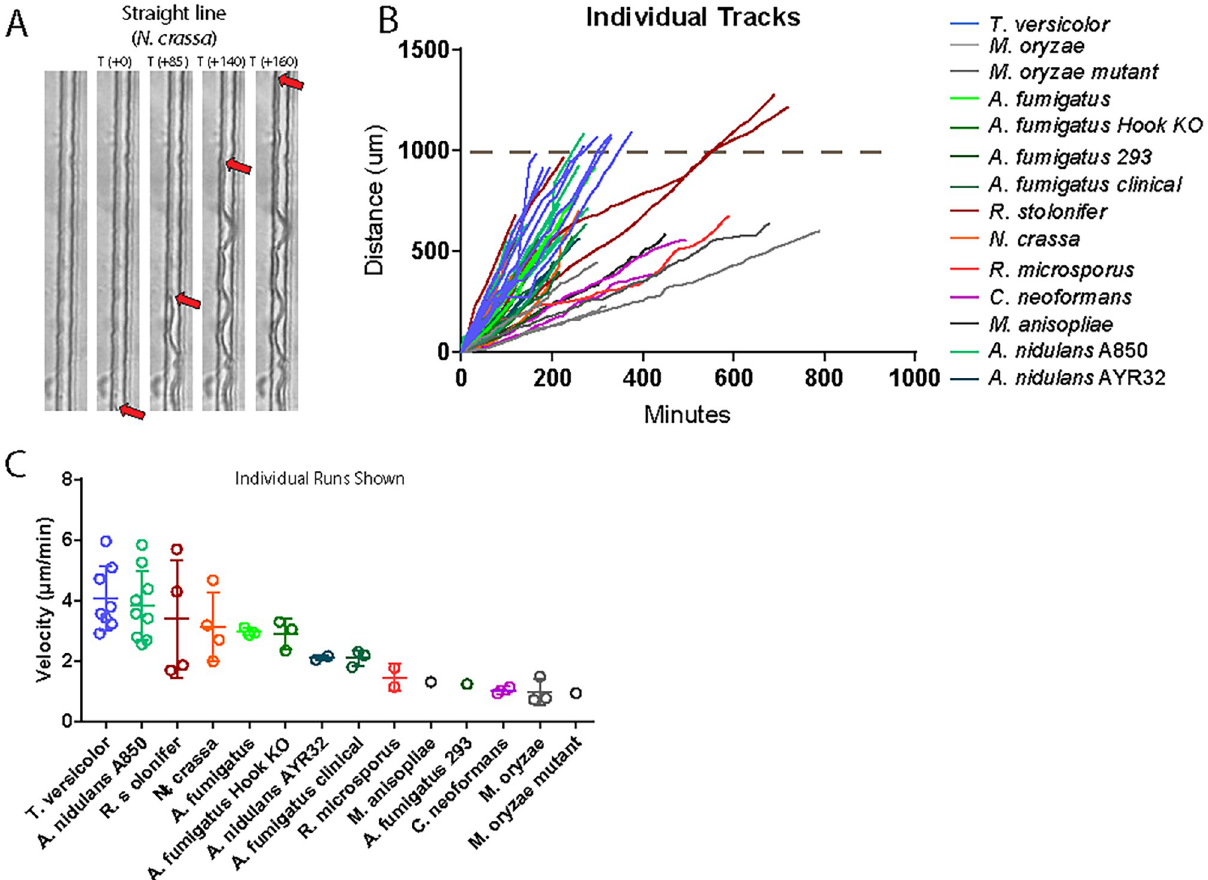
Fig 2. Fungal velocities. (A) A time series of a fungal hypha ( N . crassa ) growing in the straight channel. Red arrows indicate the leading hyphal tip, which was tracked for velocity determination. Channels are 10 μ m wide. (B) Individual tracks for each fungus are shown, plotting the cumulative distance of hyphal growth ( μ m) vs. time (min). (C) The velocities are shown for each fungus. Individual runs are presented as open circles. Lines represent averages and standard deviation.